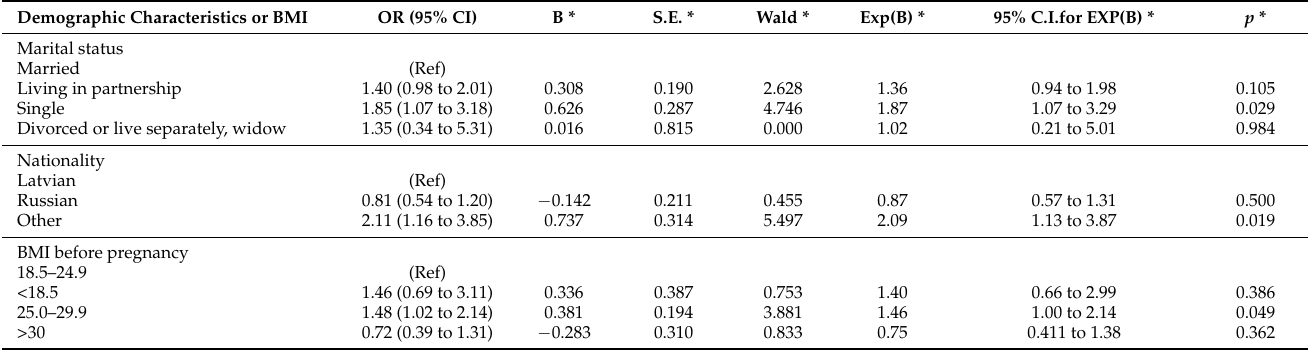
Table 4. The odds ratio of ID anaemia in the third trimester.